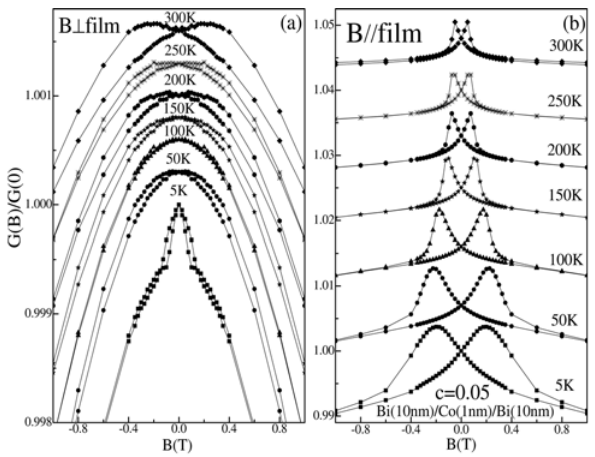
Fig. 4. Same as in fig.3 for the trilayer structure.